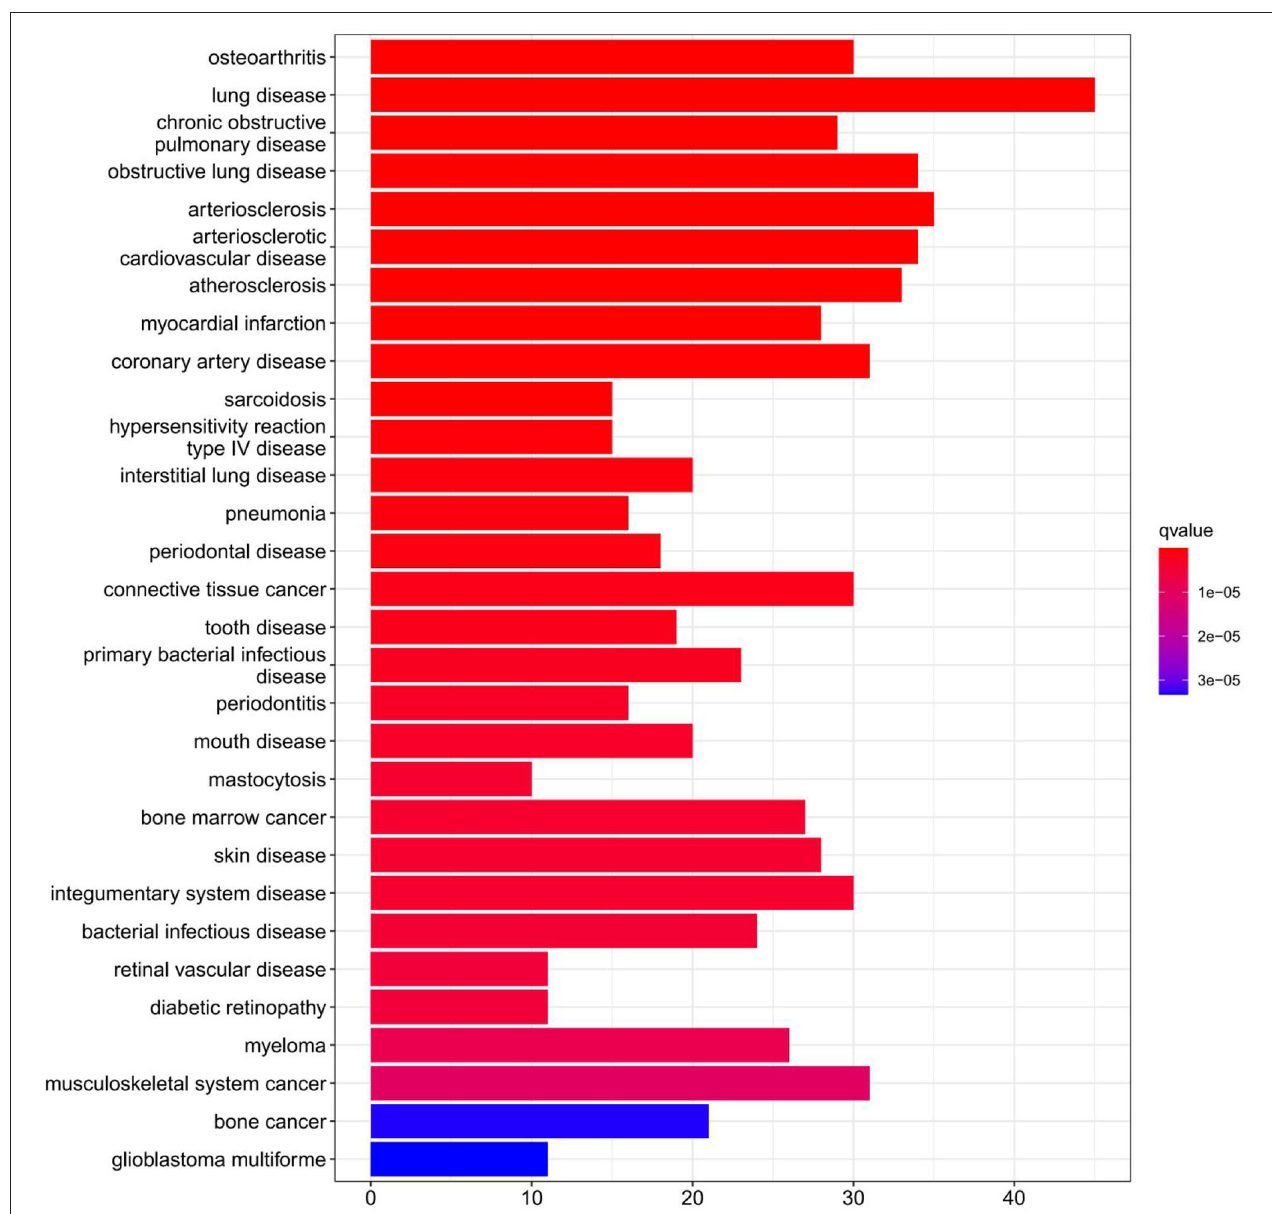
FIGURE 4 | Disease Ontology (DO) enrichment analysis was performed on DEGs and the top 30 terms were selected for visualization. The x-axis shows the number of genes enriched on the terms and the y-axis shows the pathway terms.The q-value of each term is colored according to the legend.